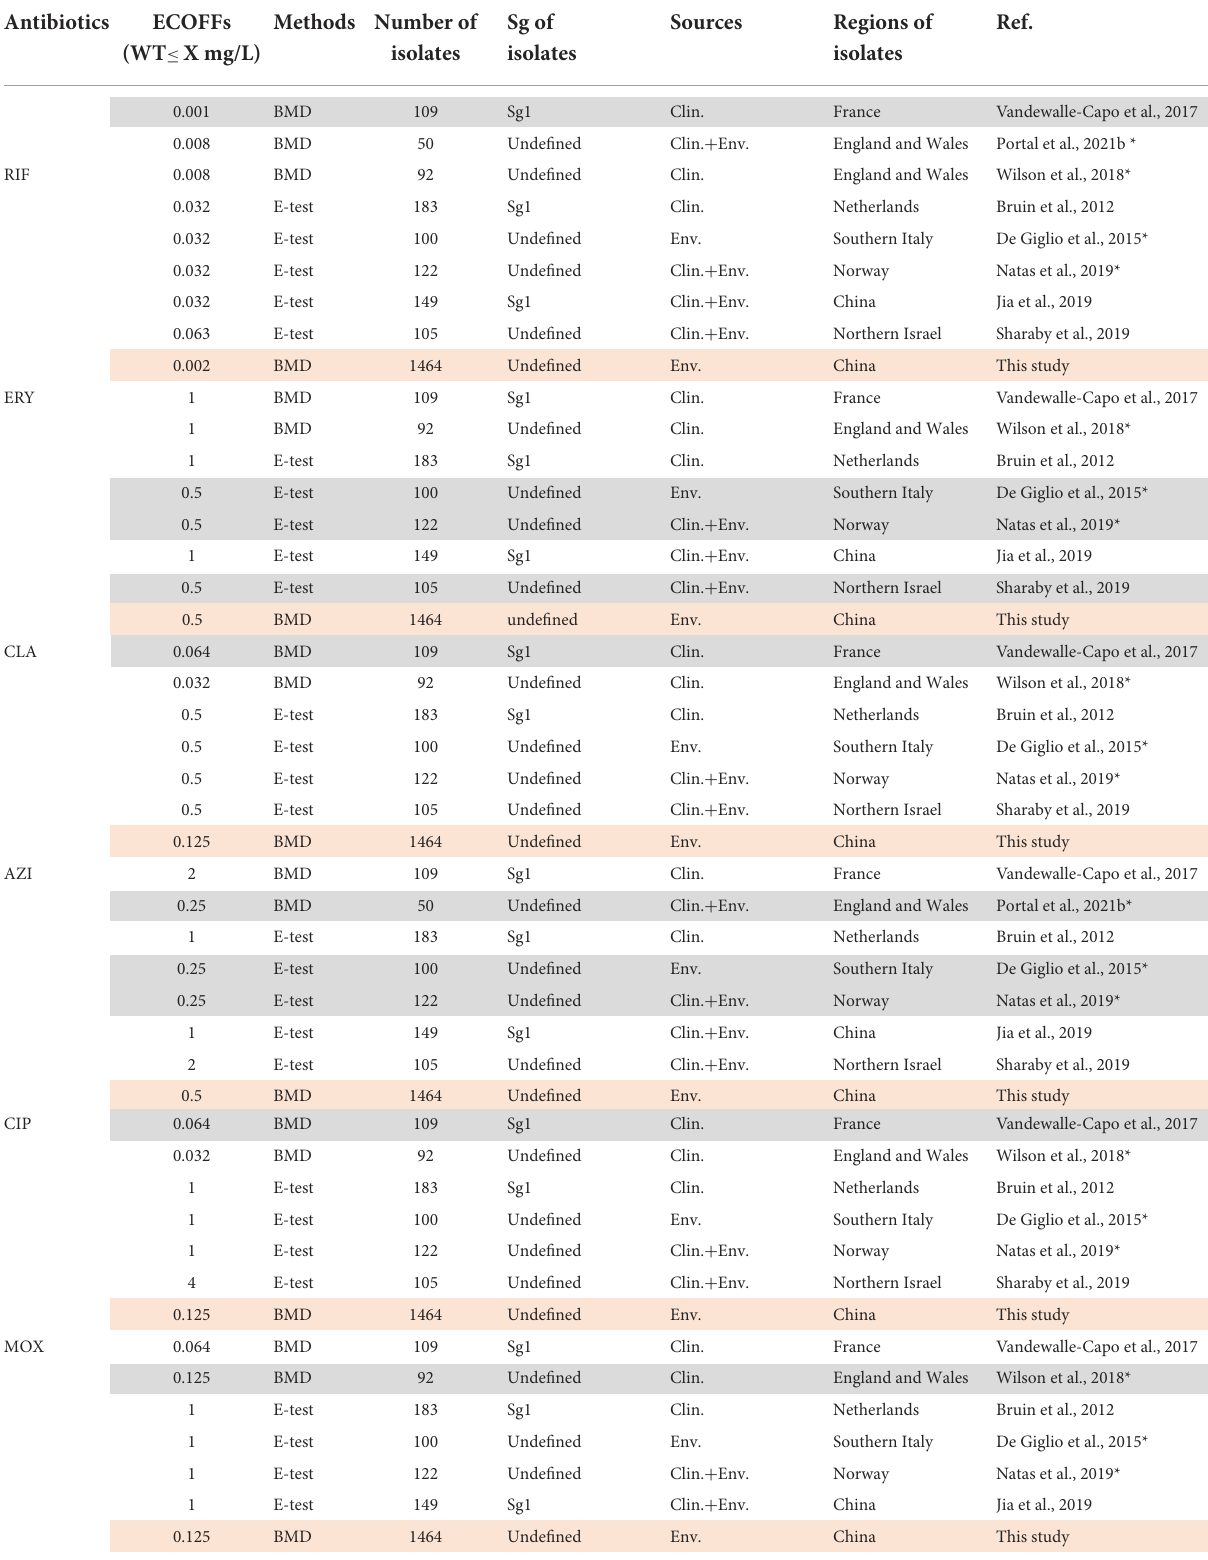
TABLE 3 Epidemiological cutoff values (ECOFFs) of antimicrobials for L. pneumophila that are described in other articles. Antibiotics